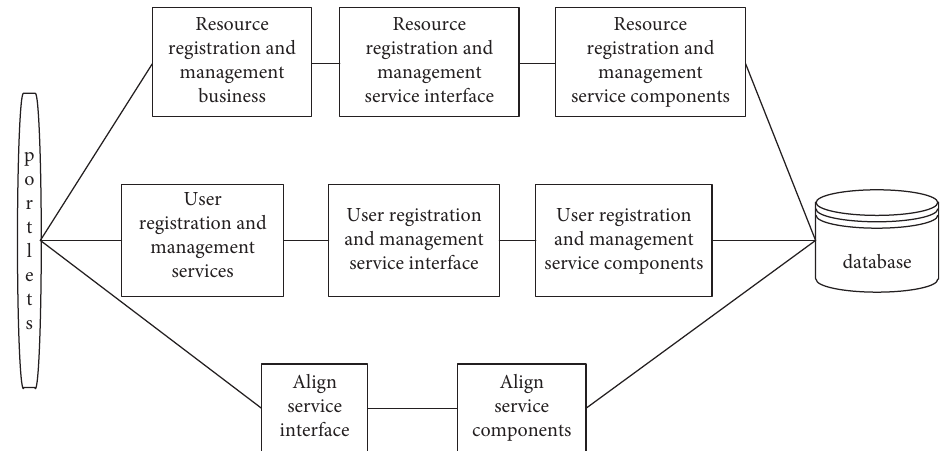
Figure 7: Schematic diagram of service